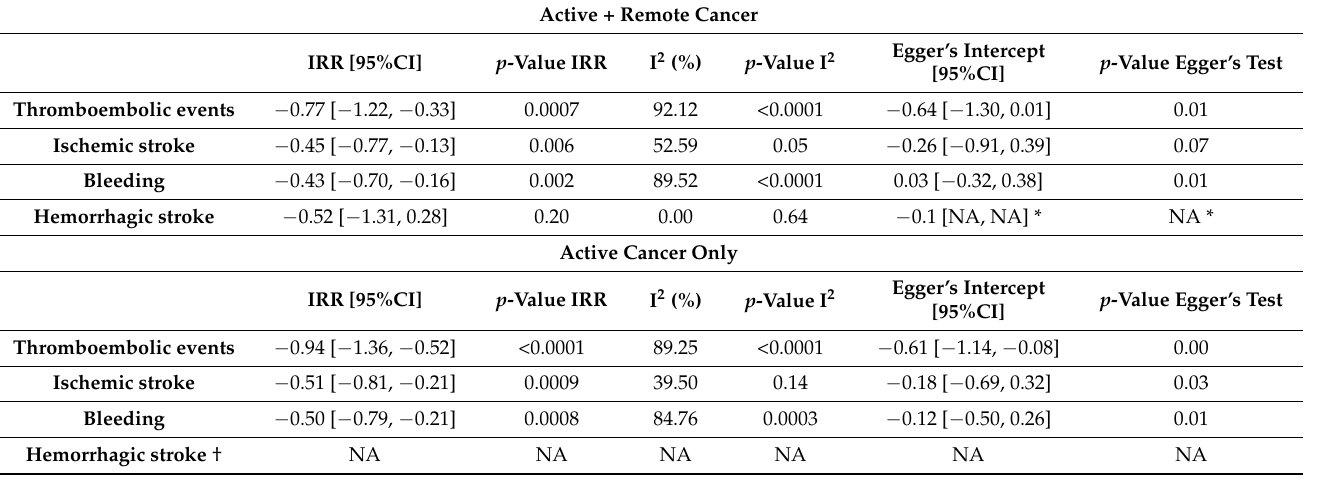
Table 3. Results of the analysis without Sawant et al. [26].